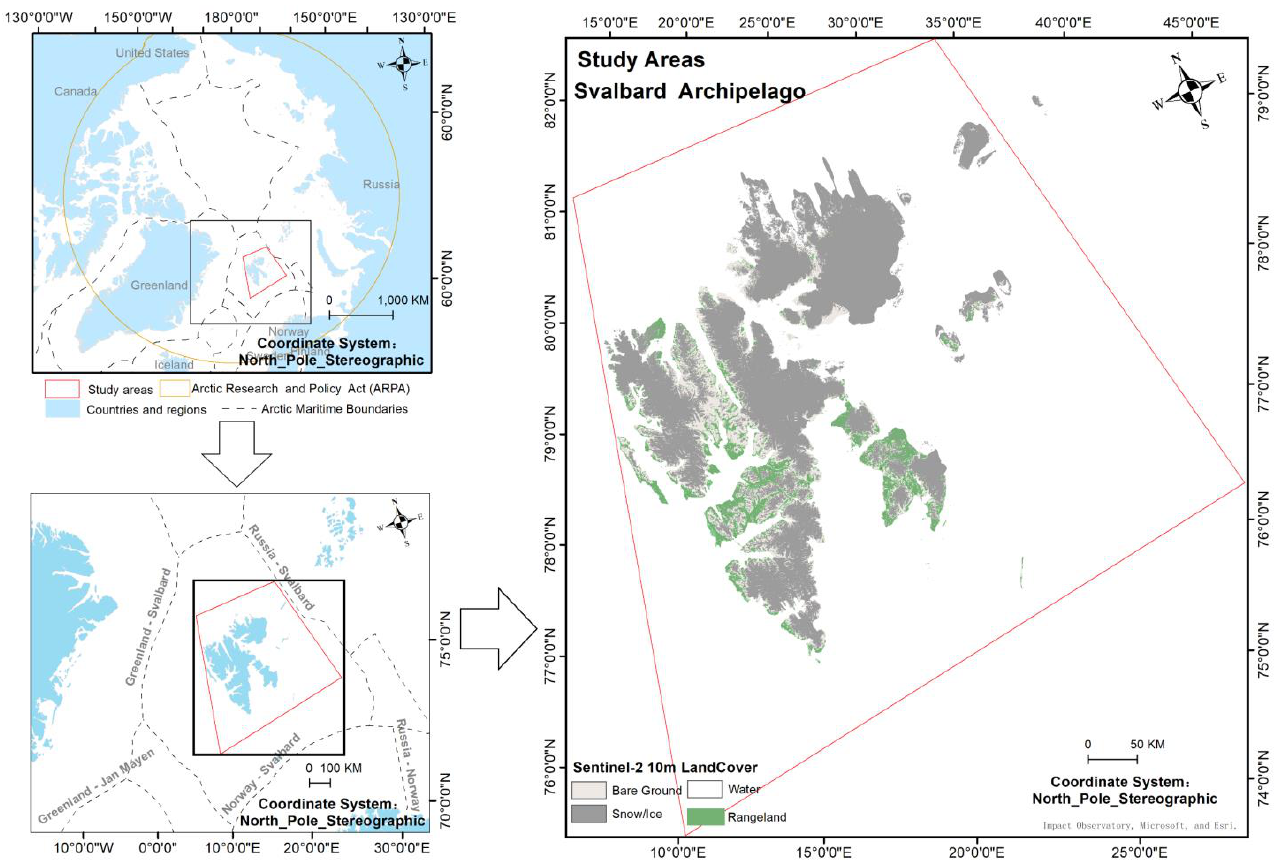
Figure 2. Study areas in Svalbard, Arctic region.